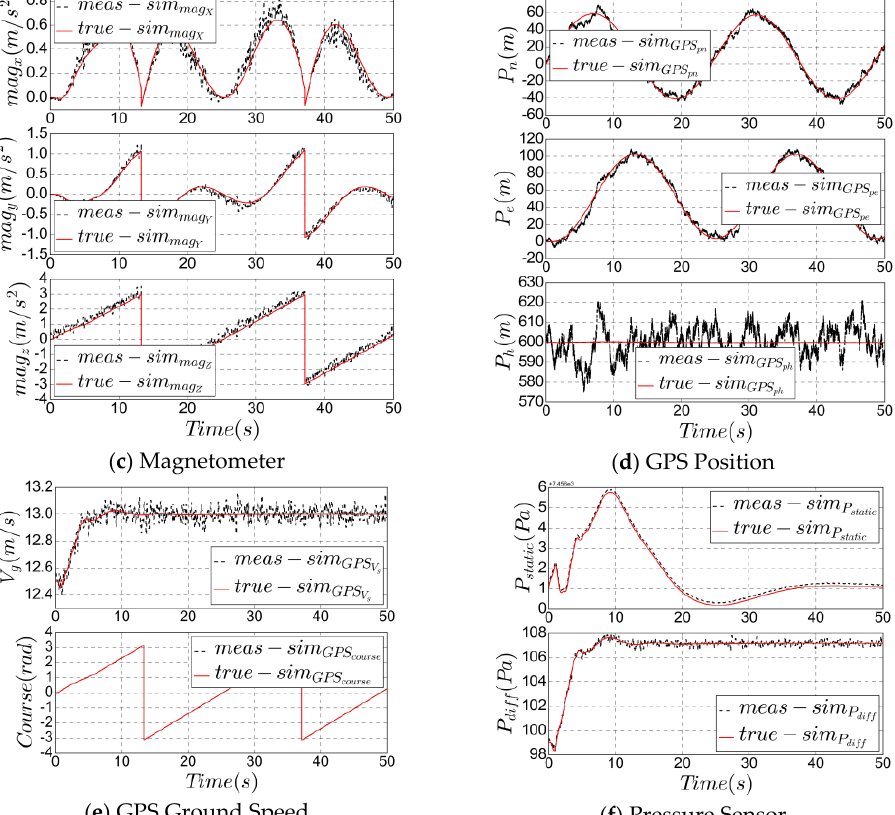
Figure 6. True states and measurement states comparison.